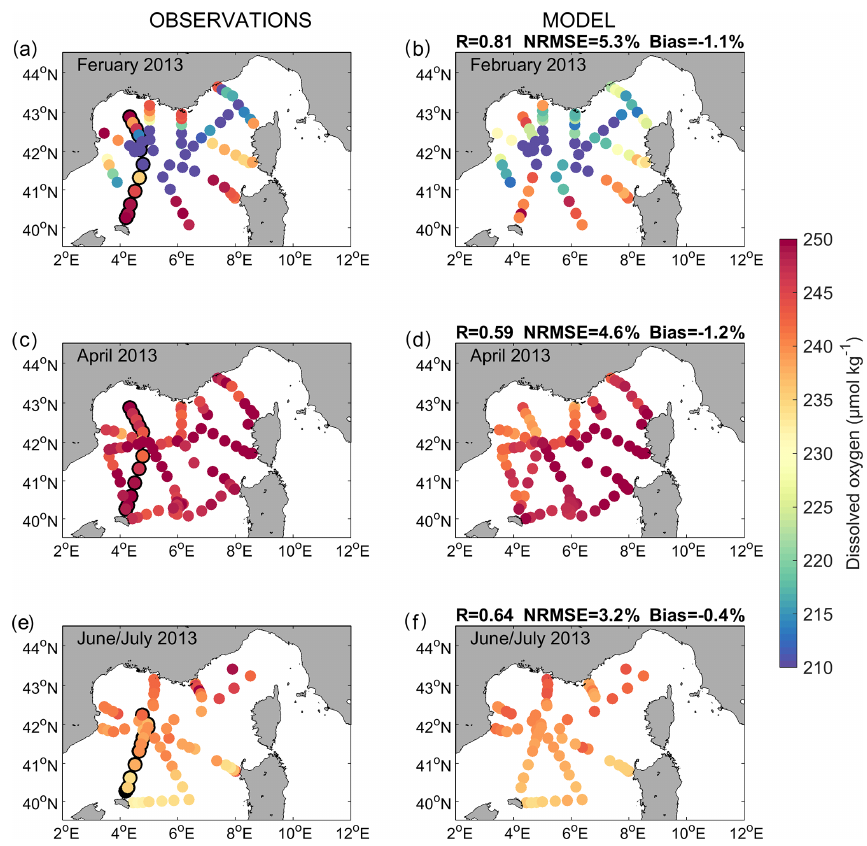
Figure 3. Surface dissolved oxygen concentration (µmolkg − 1 ) observed ( a , c and e ) and modelled ( b , d and f ) over the ( a and b ) DEWEX Leg1 (1–21 February 2013), ( c and d ) DEWEX Leg2 (5–24 April 2013) and ( e and f ) MOOSE-GE (11 June–9 July 2013) cruise periods. The black-outlined dots correspond to the measurement stations shown in Fig. 4. Table 1. Statistical analysis of model results: Pearson correlation coefficient ( R ), normalised root-mean-square error (NRMSE), percentage bias (PB) and SD ratio, calculated between modelled dissolved oxygen concentrations and observations from DEWEX winter and spring cruises and the MOOSE-GE summer cruise and from Argo-O 2